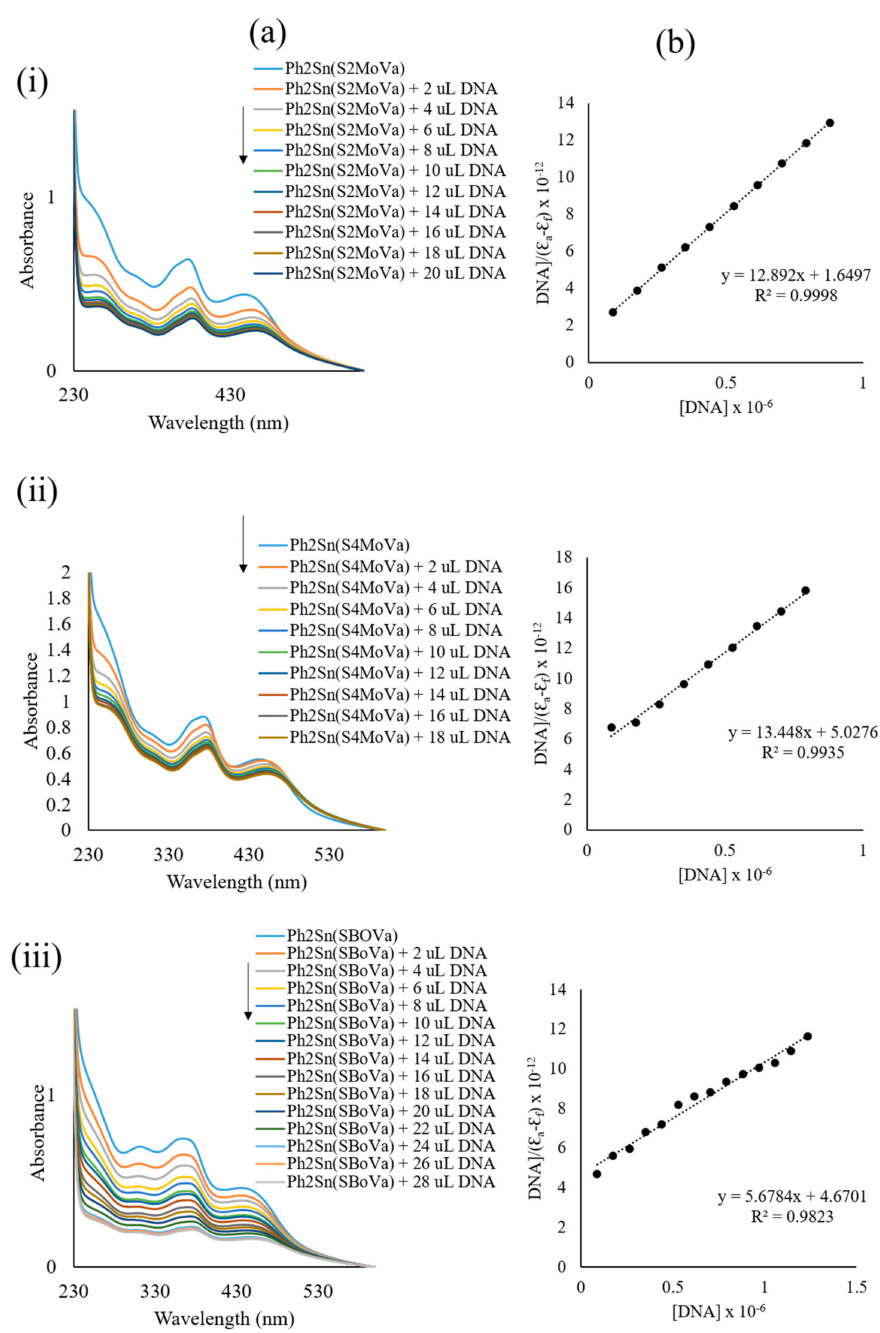
Figure 8. ( a ) Electronic absorption spectra of ( i ) Ph 2 Sn(S2MoVa), ( ii ) Ph 2 Sn(S4MoVa) and ( iii ) Ph 2 Sn(SBoVa); ( b ) Plot of [DNA]/ ε a − ε f vs. [DNA] for absorption titration of DNA with ( i ) Ph 2 Sn(S2MoVa), ( ii ) Ph 2 Sn(S4MoVa) and ( iii ) Ph 2 Sn(SBoVa). The arrow indicates the change in absorbance in tandem with increasing DNA